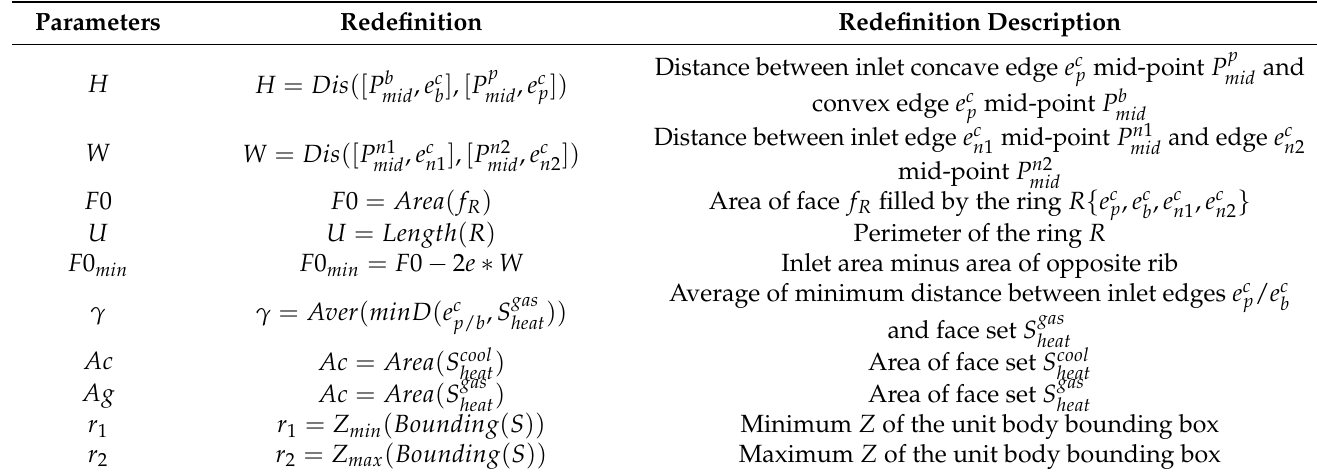
Figure 29. Spoiler fin unit geometric composition and functional decomposition. Table 3. Analysis parameters redefinition.